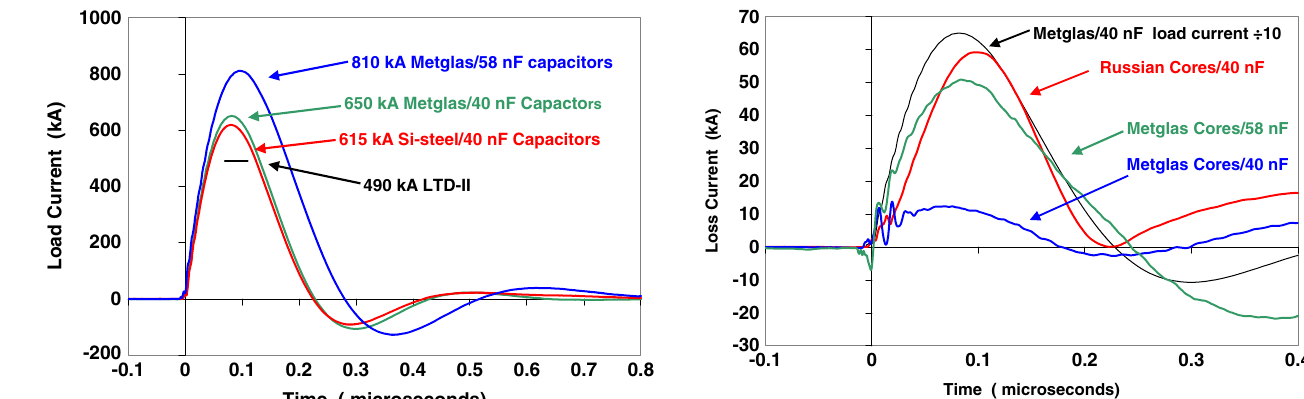
FIG. 8. LTD-III peak currents into matched loads with 40 nF capacitors and Si-steel toroids (red), 40 nF capacitors and Metglas (cid:1) toroids (green), and 58 nF capacitors and Metglas (cid:1) toroids (blue). Peak LTD-II current levels are shown for comparison.